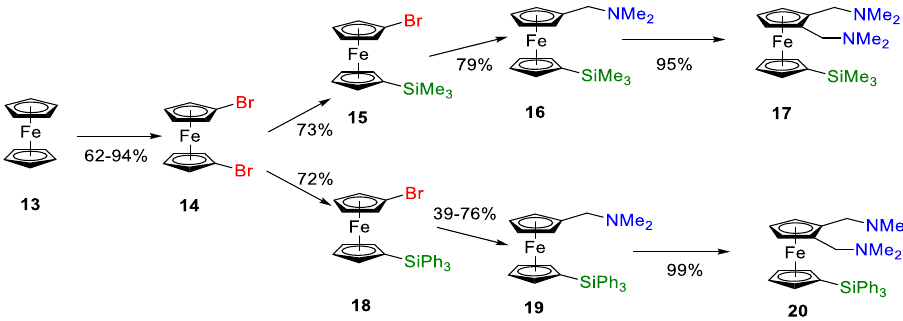
Figure 10. Preparative route to bulky alkyl- or aryl-sily-ferrocenylmethylamine ligands. The synthetic route uses 1, 1′ -dibromoferrocene, 14 , as a key intermediate, as it is easy